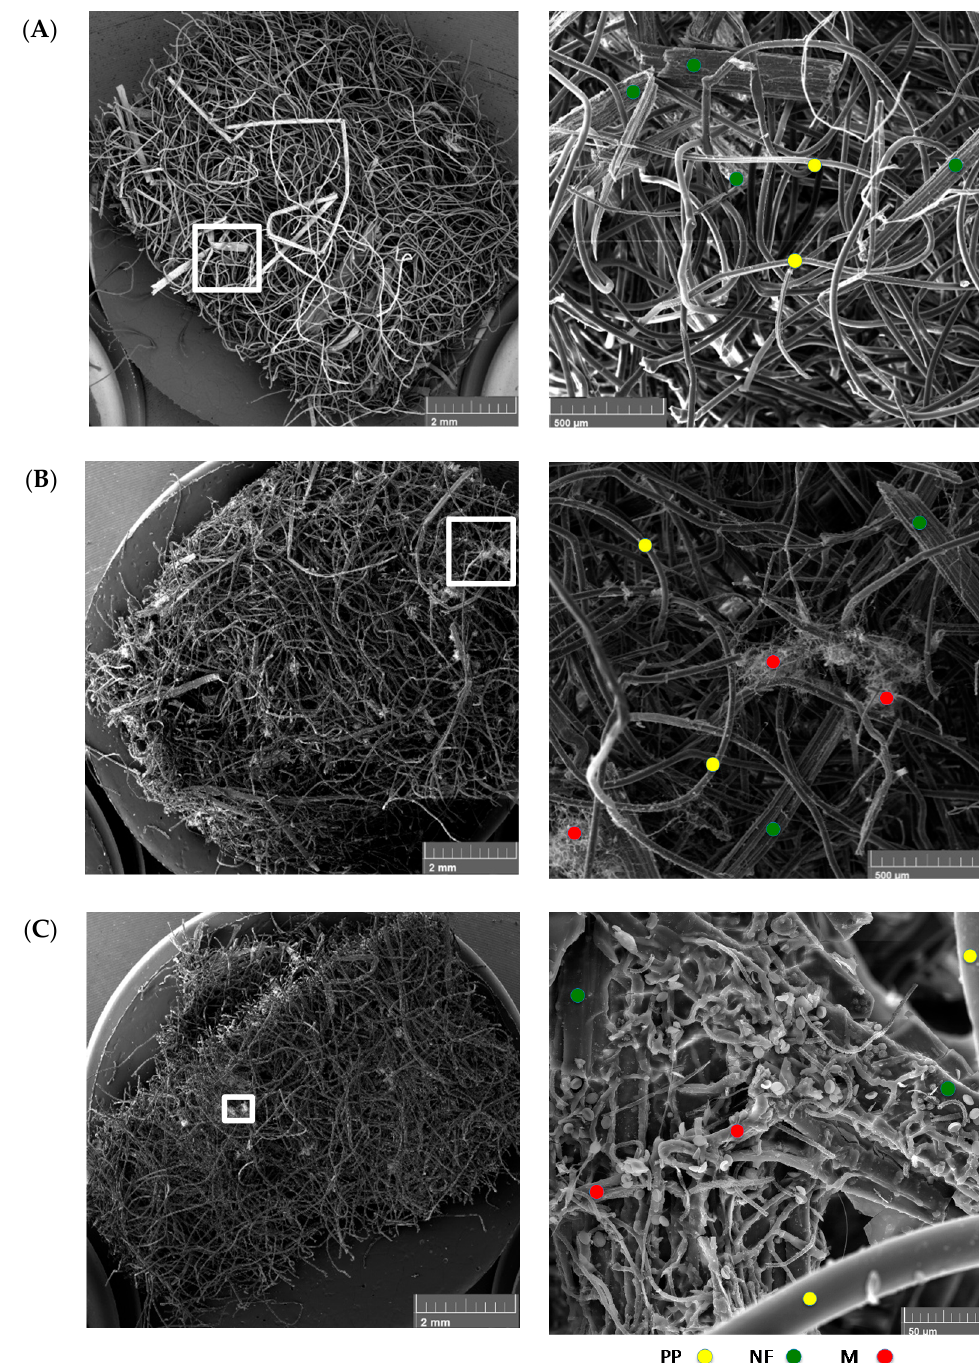
Figure 5. SEM micrographs with low (left) and high (right) magnification for the flax-PP dry mats at t 28 under different exposure conditions. The conditions included ( A ) no water-no fungi, ( B ) yes water-no fungi, and ( C ) yes water-yes fungi. Similar to the hemp fiber composite, here ( B ) indicated that there have been omnipresent fungal species in the NFRC prior to its processing. Yellow, green and red circles indicate the presence of sample PP fibers, natural fibers, and mycelium fungus. Also notice the clear presence and extent of fungal spores (white dots) in the 25X magnified image ( C ).